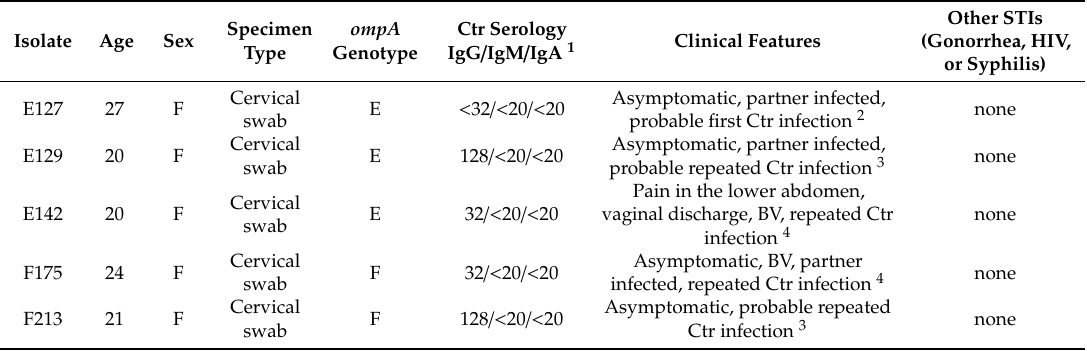
Table 1. Characteristics of the five patients whose C. trachomatis isolates were included in the in vitro gene expression